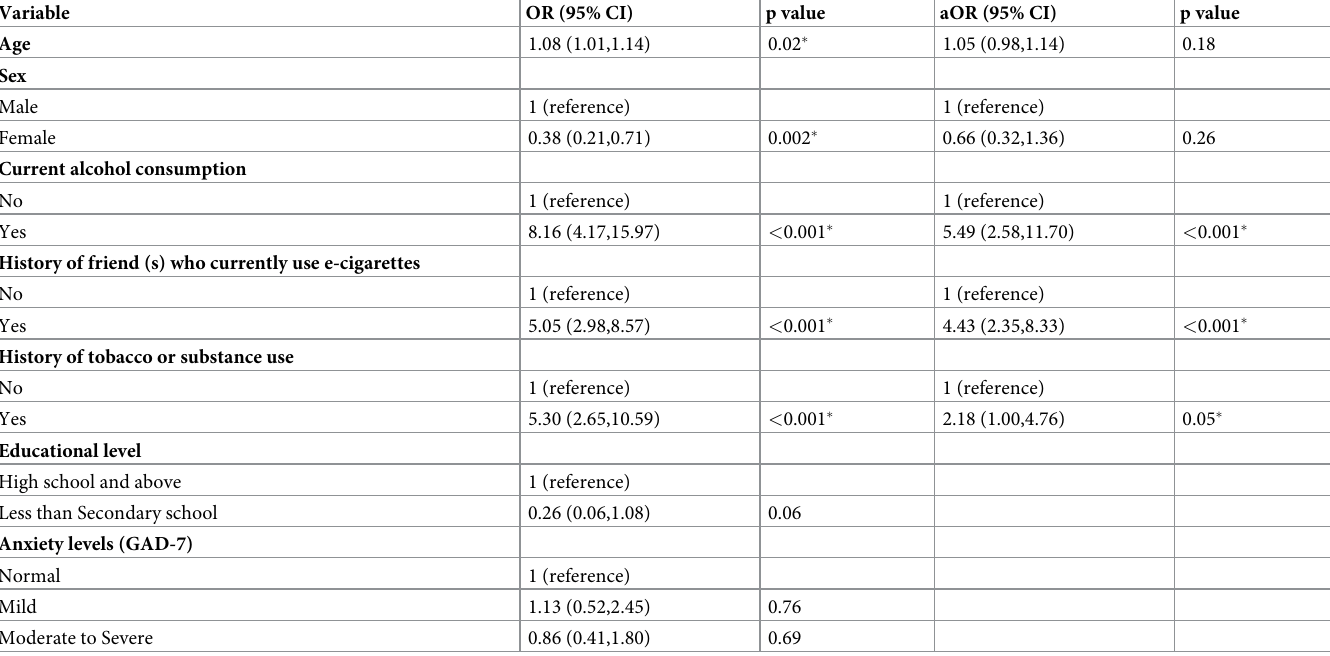
Table 4. Factors associated with E-cigarette